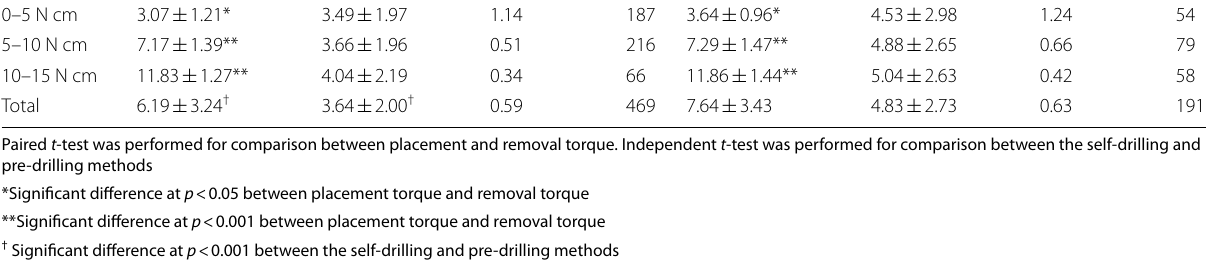
Table 5 Comparison between placement torque and removal torque according to placement torque range and placement method, and comparison of overall torque values between the self‑drilling and pre‑drilling methods Placement Self-drilling (N torque range